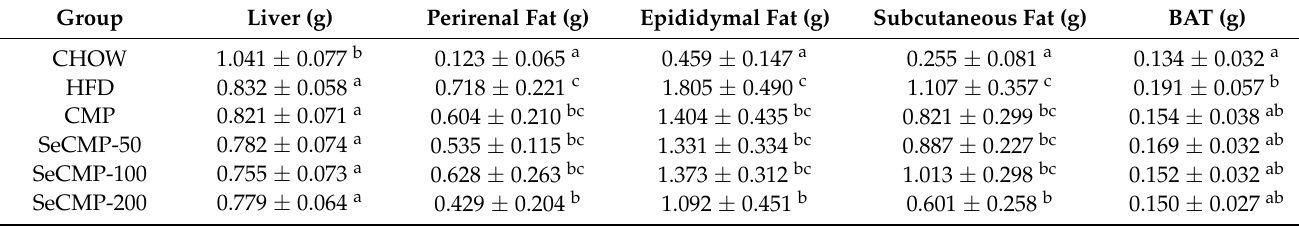
Table 2. Weight of liver and adipose tissues of mice under different feeding